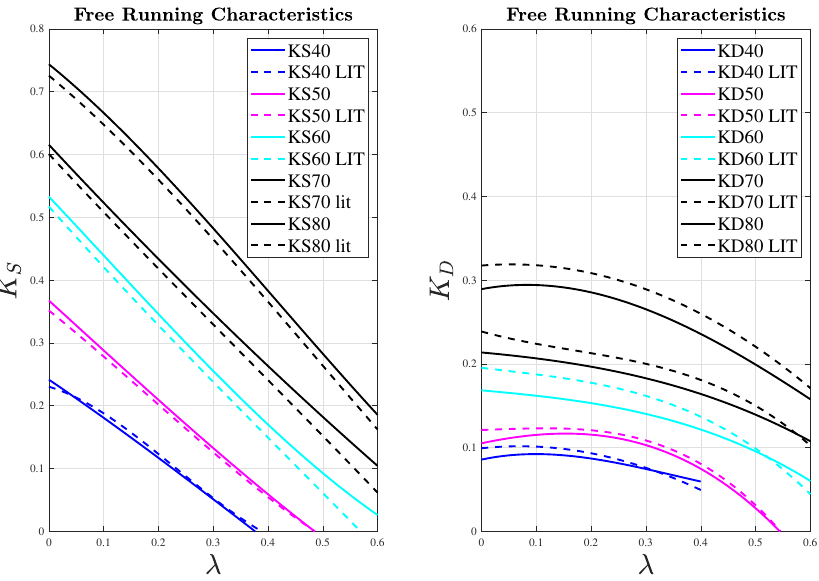
Figure 8. Thrustandtorquepropellercoefficients: model(solidlines)VSmanufacturer(dashed lines)